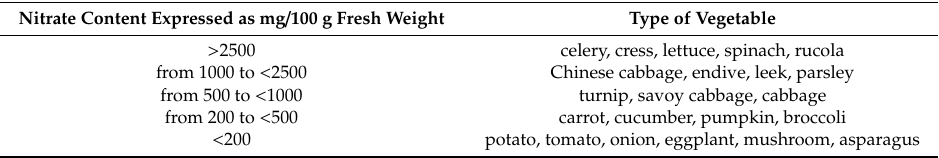
Table compiled according to